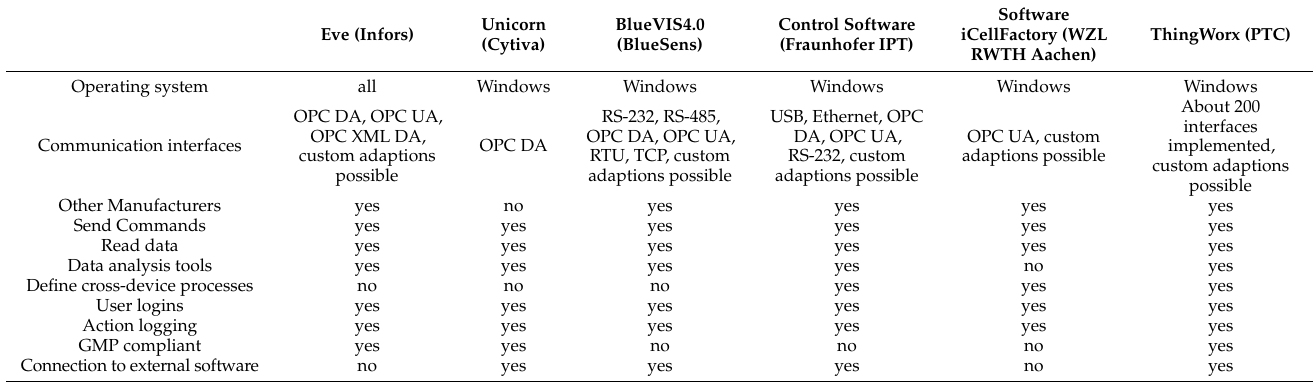
Table 1. Overview of different software for controlling automated biotechnological processes. Eve (Infors) Unicorn (Cytiva) BlueVIS4.0 (BlueSens) Control Software (Fraunhofer IPT)